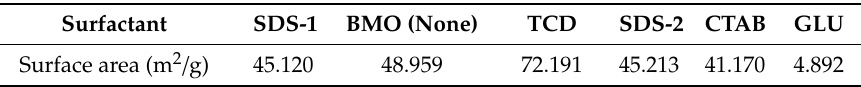
Table 1. The specific surface area data of Bi2MoO6